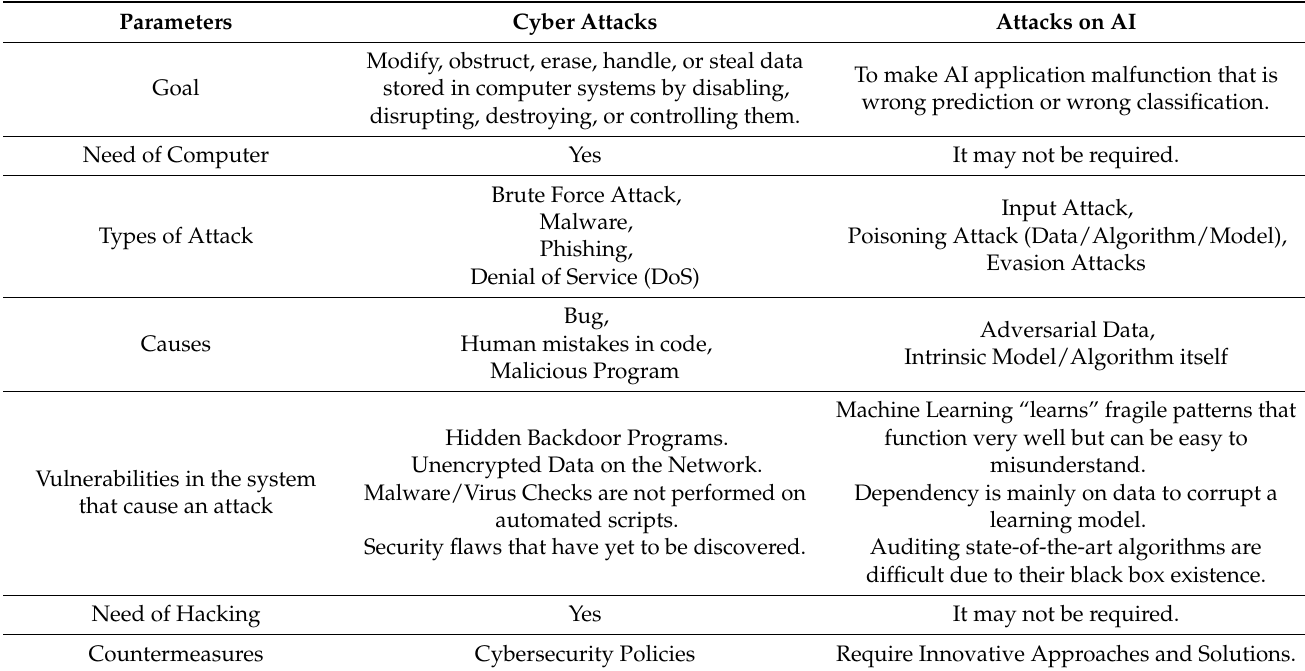
Table 19. Cyberattack vs. attacks on